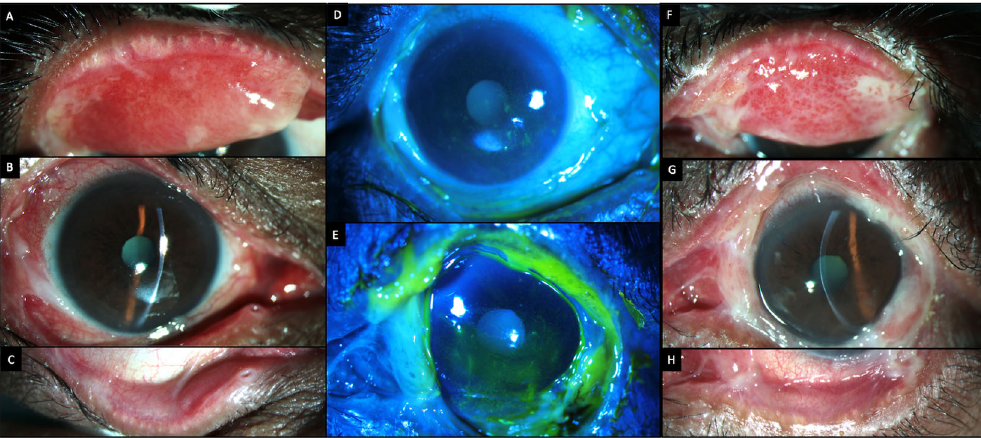
granulation tissue and cicatricial changes which are more advanced than those of the right